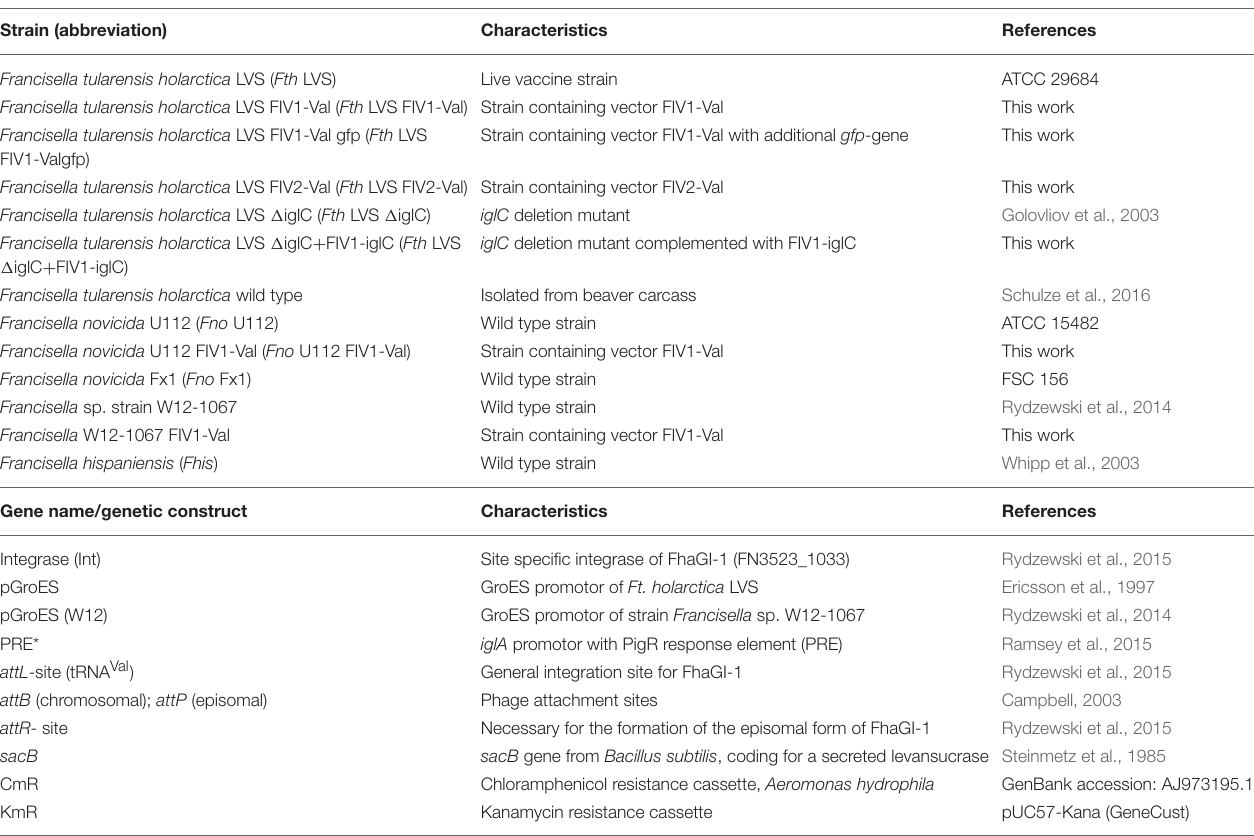
TABLE 1 | Strains and genetic elements used in this